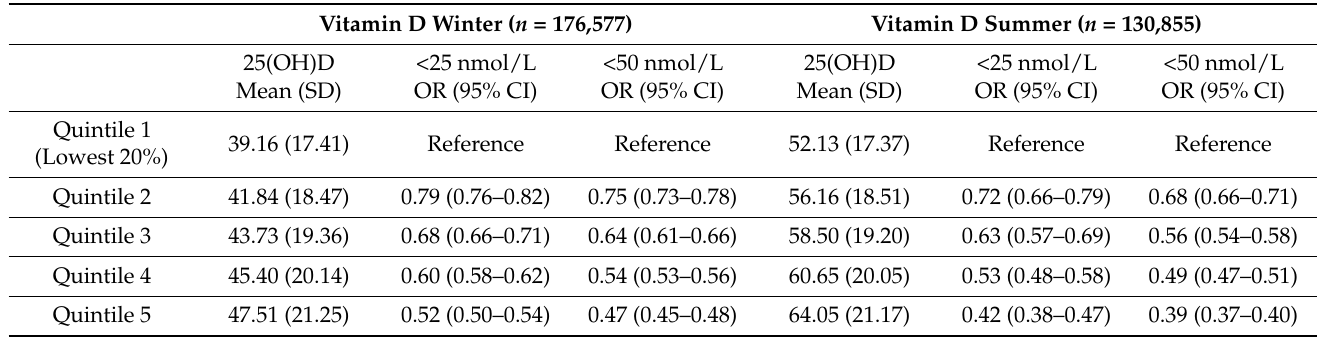
for measurement, assessment centres, SNP array, and top 40 genetic principal components. Vitamin D winter classified as November to May and vitamin D summer as June to October, based on distribution of